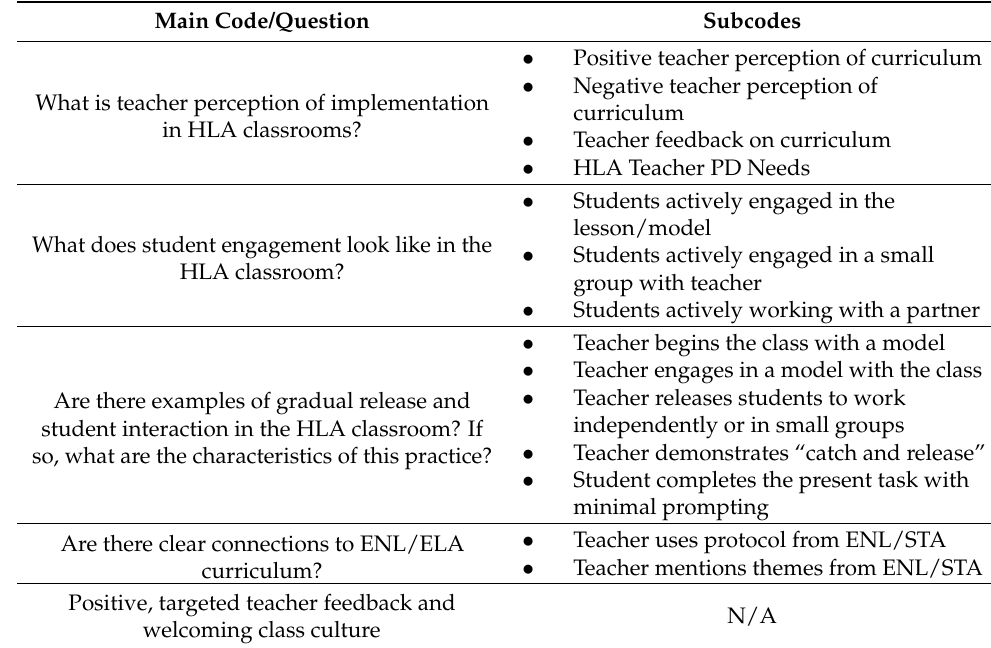
Table 2. Qualitative Coding